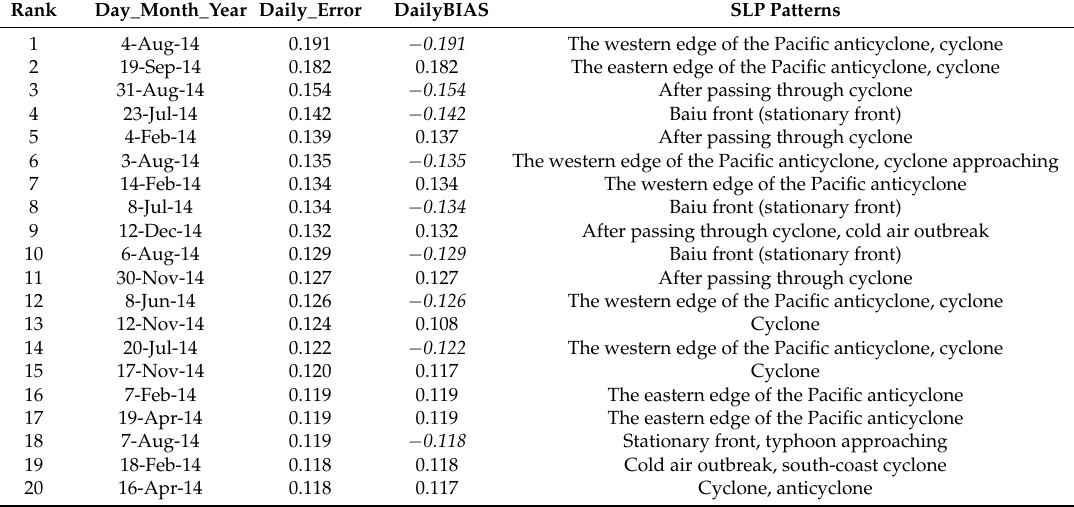
Table 2. Top 20 outlier events in regionally integrated GHI day-ahead forecasts for nine electric power grids during 2014. “Daily_Error” and “Daily_BIAS” denote daily absolute errors and mean bias errors, respectively. “Surface sea level pressure (SLP) patterns” for each day were judged by the authors based on JMA weather